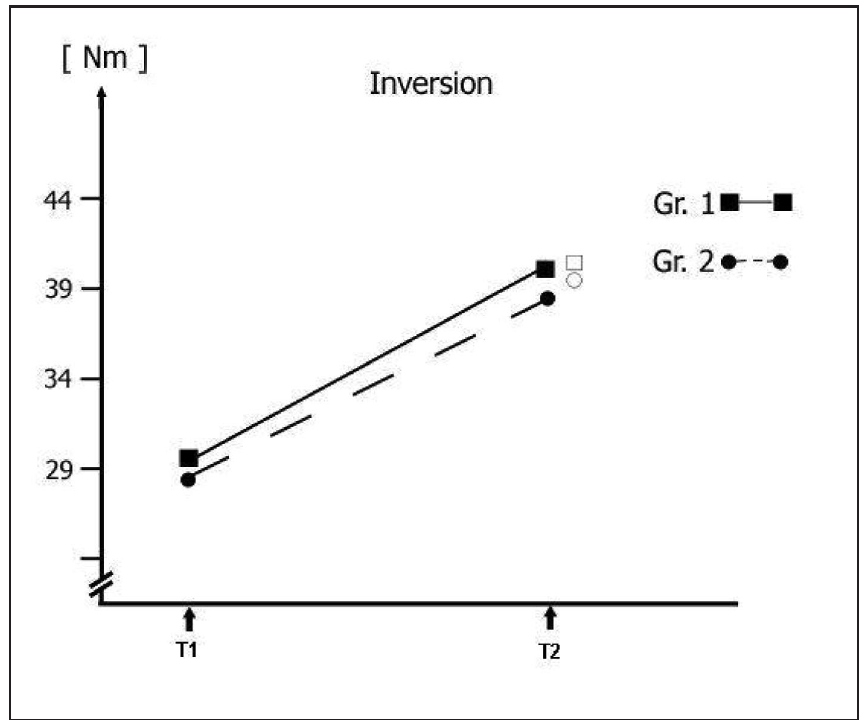
treatment).Figure 4: Maximum isokinetic torque in the inversion of the injured ankle in the comparison groups at the beginning of the investigation (T ) and at the end of the investigation (T 1 torque on the uninjured